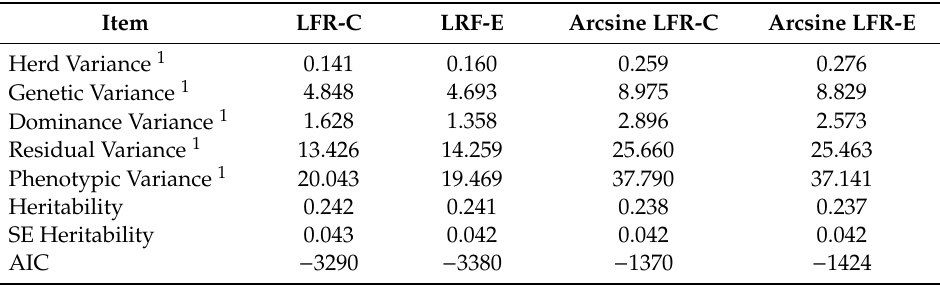
Table 4. Results of genetic analysis carried out on the lifetime fertility rate (LFR) obtained combining actual and predicted number of foals after 6 breeding seasons and considering di ff erent prediction methods for incomplete reproductive career (by coe ffi cients; LFR-C; by equations; LFR-E) and arcsine transformation of both the LFR-C (Arcsine LFR-C) and the LFR-E (Arcsine LFR-E). Item LFR-C LRF-E Arcsine LFR-C Arcsine LFR-E Herd Variance 1 0.141 0.160